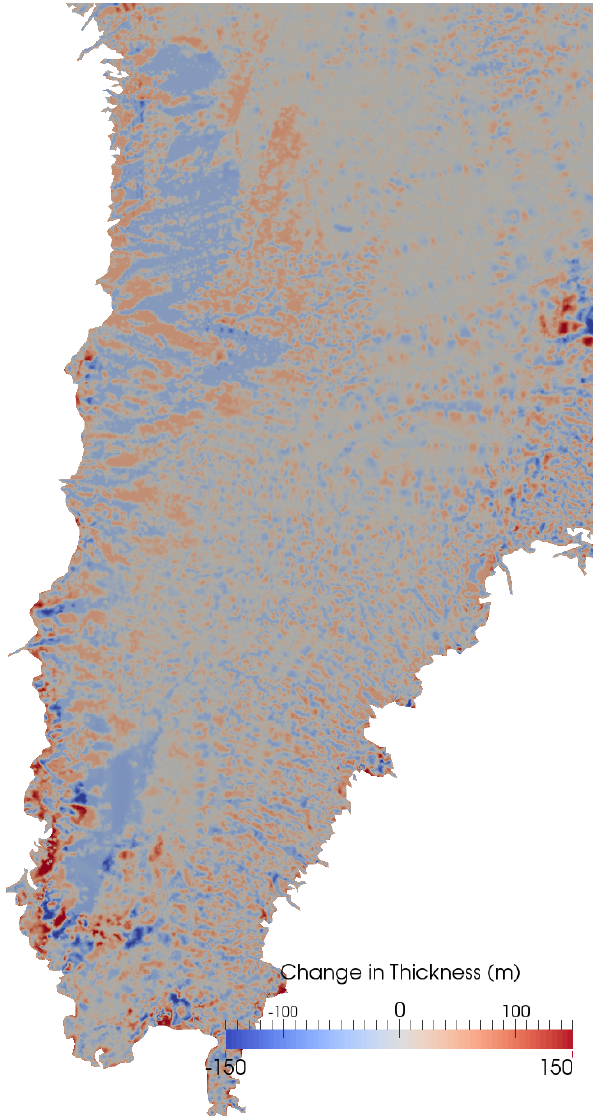
Figure 5. Differences between the ice thicknesses reported in Bam- ber et al. (2013) and the thicknesses found at the end of the opti- mization procedure.